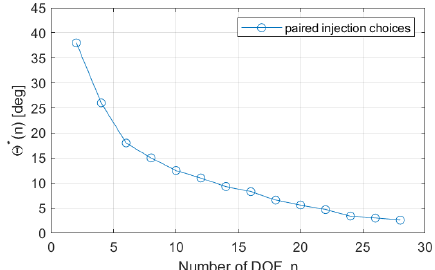
Figure 6. The maximum angle θ ∗ ( n ) formed between a subspace of n DOFs and any other injection choices outside this subspace decreases as the number of DOFs